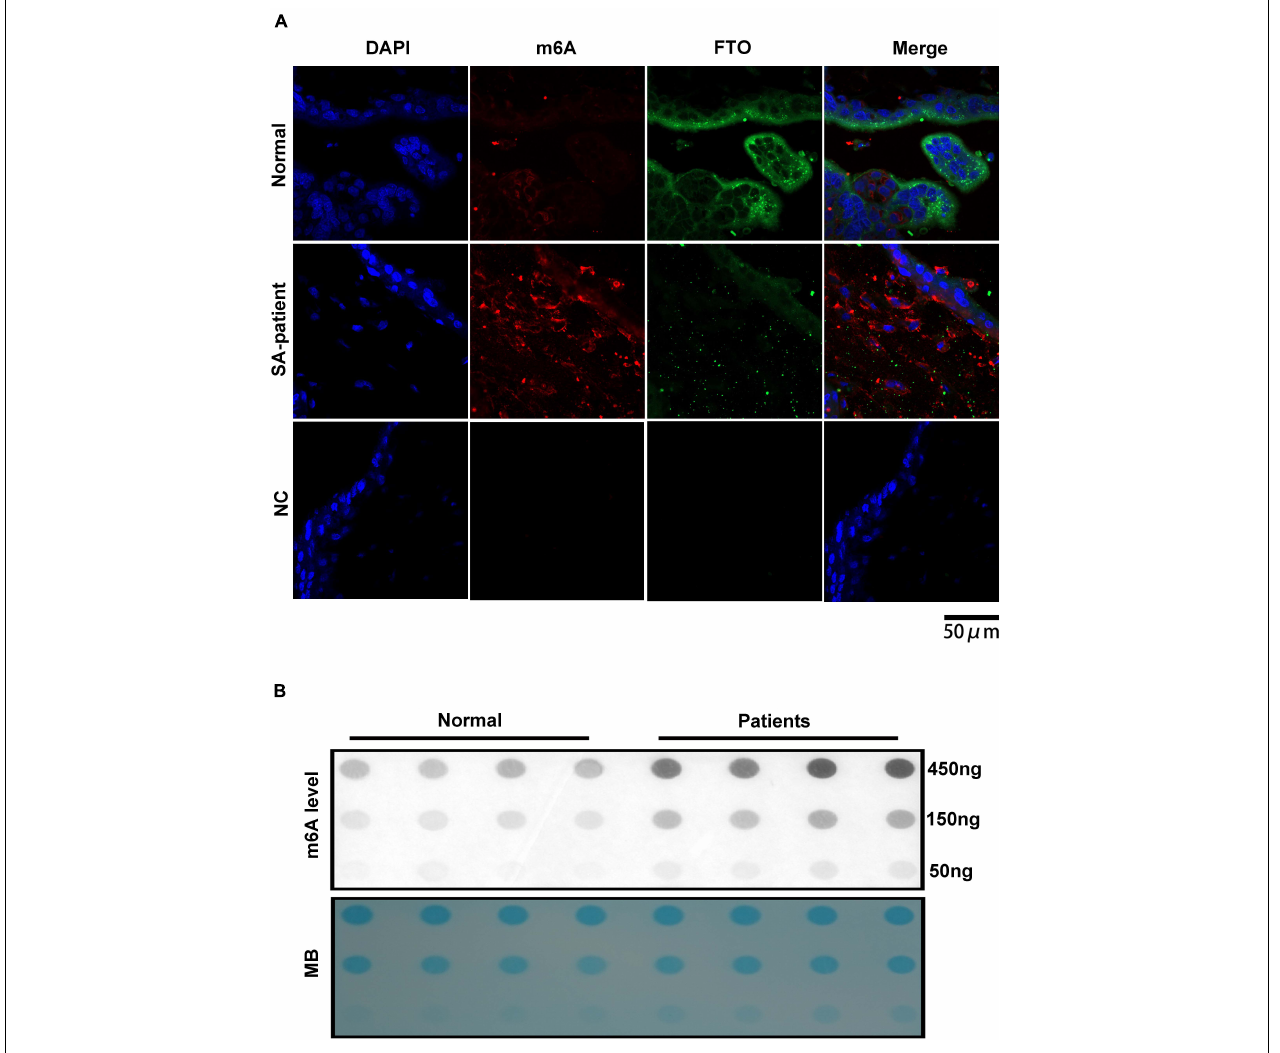
FIGURE 4 | (A) Representative immunofluorescence images of chorionic villi showing in situ expression of FTO and m 6 A in both groups (Normal n = 3; Patient n = 3; NC:negative control n = 3). Blue – FTO and red – m 6 A. (B) Poly(A)+ RNAs isolated from chorionic villi were used in dot blot analyses with m 6 A antibody. RNA was loaded by equal dilution method (Normal n = 4; Patient n =